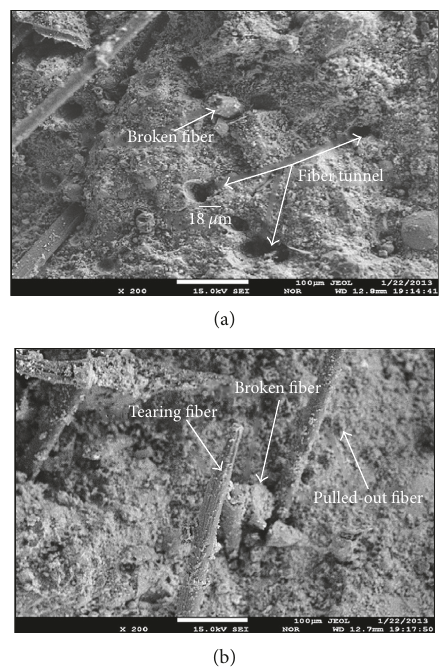
Figure 5: Typical cracking surface under the optical investigation of ECC specimen